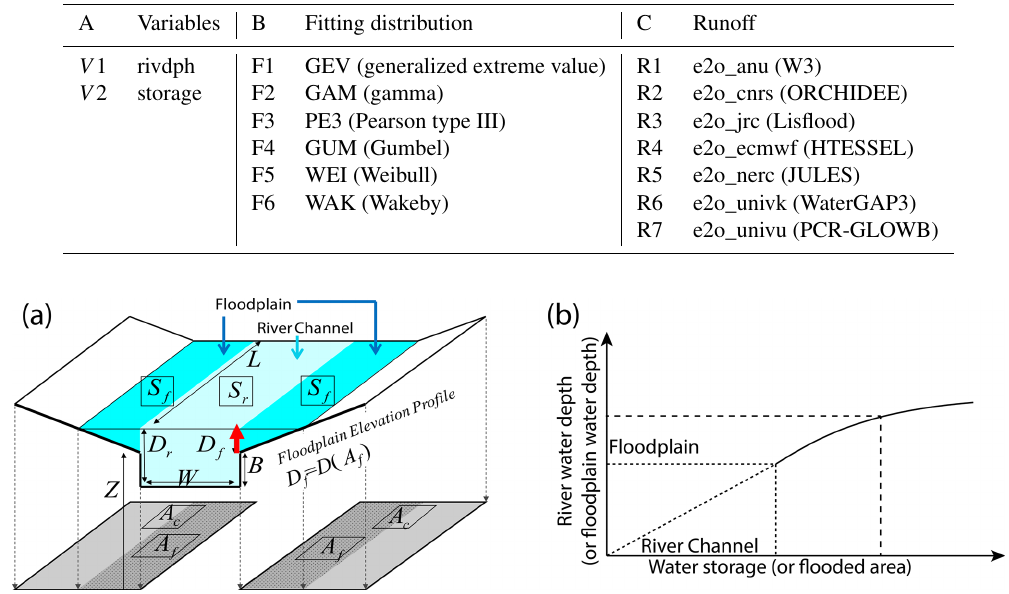
Figure 1. (a) Illustration of a river channel reservoir and a floodplain reservoir defined in each unit catchment. The water level for the river channel and floodplain is assumed to be the same in each unit catchment. The denotation of each parameter and its calculation refer to (Yamazaki et al., 2011). (b) The relationship between the water level and water storage (or flooded area) for a specific unit catchment. The shape of the curve within the river channel is determined by the profile of the river channel, and the curve above the river channel is mainly affected by floodplain